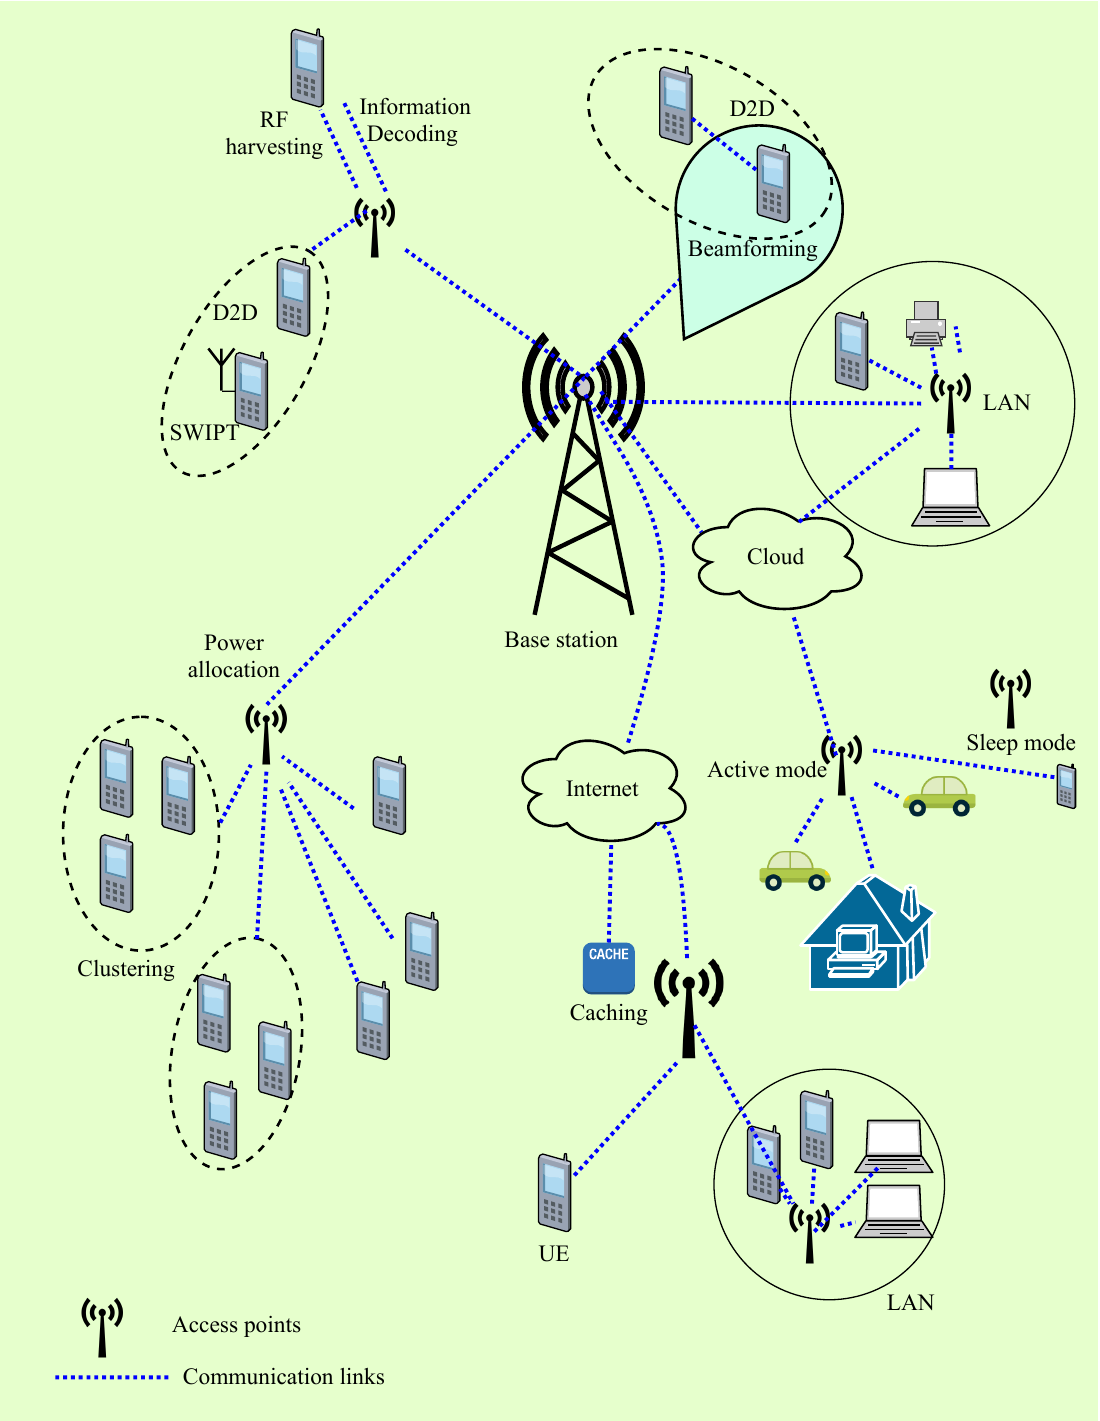
Figure 1. Existing schemes of enhancing energy efficiency in NOMA based wireless networks such as power allocation, RF energy harvesting, cooperative communications (D2D, M2M), cloud, caching, beamforming, sleep/active